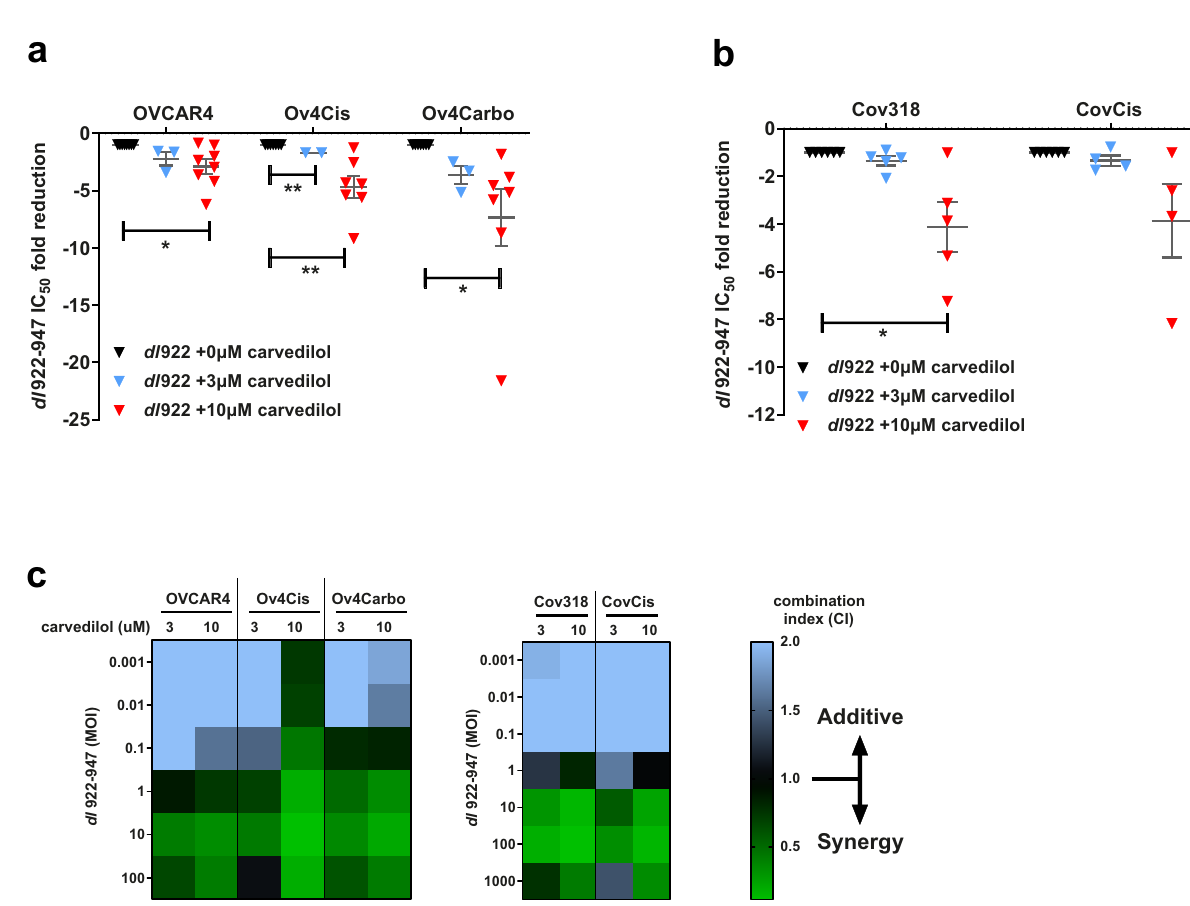
Fig. 1 Carvedilol synergises with dl 922-947 in HGSC cell lines. a Fold reductions of dl 922-947 IC 50 in CTG assays following carvedilol treatment compared to virus alone in the OVCAR4 panel (OVCAR4 + vehicle: n = 8, + 3 μ M: n = 3, + 10 μ M: n = 8; Ov4Cis + vehicle: n = 7, + 3 μ M: n = 3, + 10 μ M: n = 7; Ov4Carbo + vehicle: n = 8, + 3 μ M: n = 3, + 10 μ M: n = 8 biological repeats; mean ± SEM; paired t -test, * P ≤ 0.05; ** P ≤ 0.01). b Fold reductions of dl 922-947 IC n = 5; CovCis: n = 4 biological repeat; 50 in CTG assays following carvedilol treatment compared to virus alone in Cov318 panel (Cov318: mean ± SEM; paired t -test, * P ≤ 0.05). c Combination Index heatmaps between carvedilol and dl 922-947 calculated from ATP-based viability